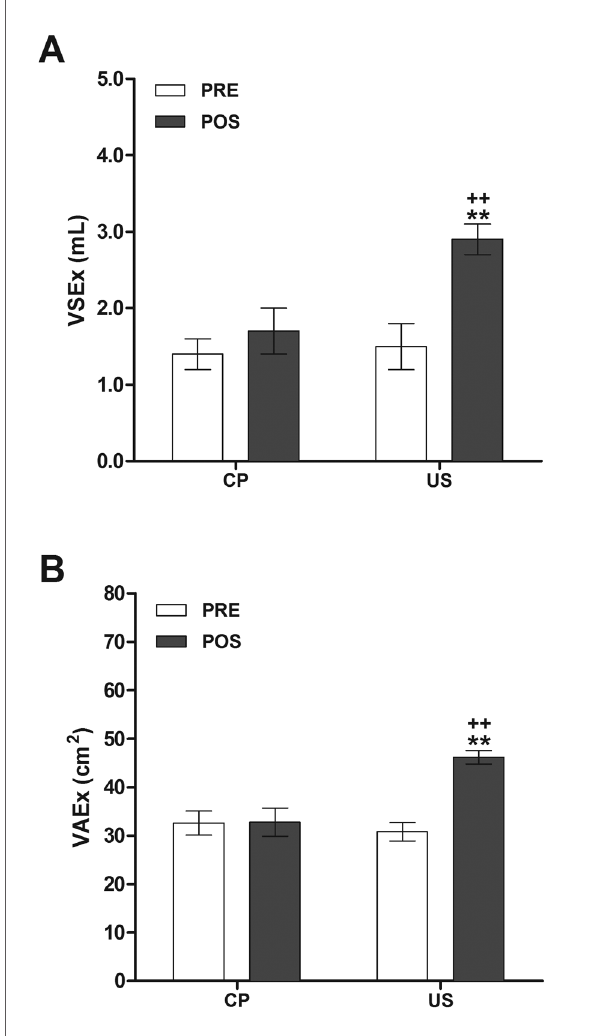
Figura 1. Efeitos da aplicação nasal da terapia ultrassônica de baixa intensidade (TUSBI) no nível de obstrução nasal de indivíduos com rinossinusite crônica (RNC). - Painel (A), volume de secreção nasal expelida (VSEx, mL). Painel (B), volume de ar expirado (VAEx, cm 2 ) nos grupos controle-placebo (CP) e irradiados (US) com TUSBI de 1-MHz (1W.cm- 2 ). Valores apresentados como média ± desvio padrão.